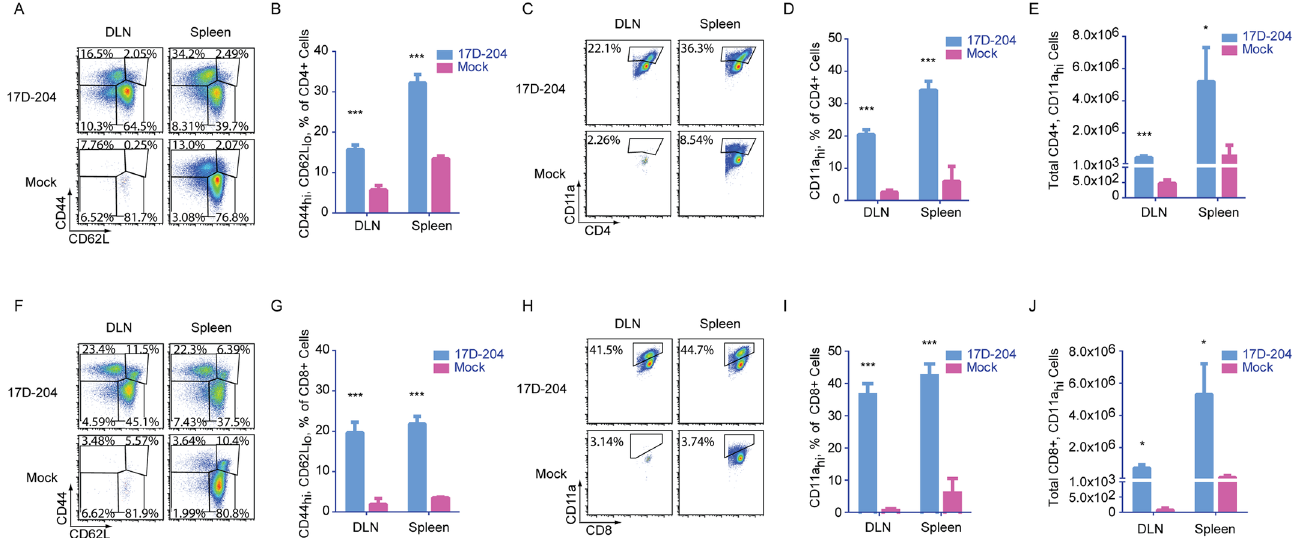
Fig 6. 17D-204 immunization induces robust T cell responses. 5 – 6 week old mice were immunized with 17D-204. On d7 post immunization DLNs and spleens were harvested and (A-E) CD4+ and (F-J) CD8+ T cells were screened by flow cytometry for the expression of (A-B, F-G) CD44 and CD62L and (C-E, H-J) CD11a. Results are representative of two experiments (n = 3 mock, n = 6 17D-204). Data are displayed as mean ± SD. *** , p (cid:1) 0.0001; * , p (cid:1) 0.01 as determined by a Student's